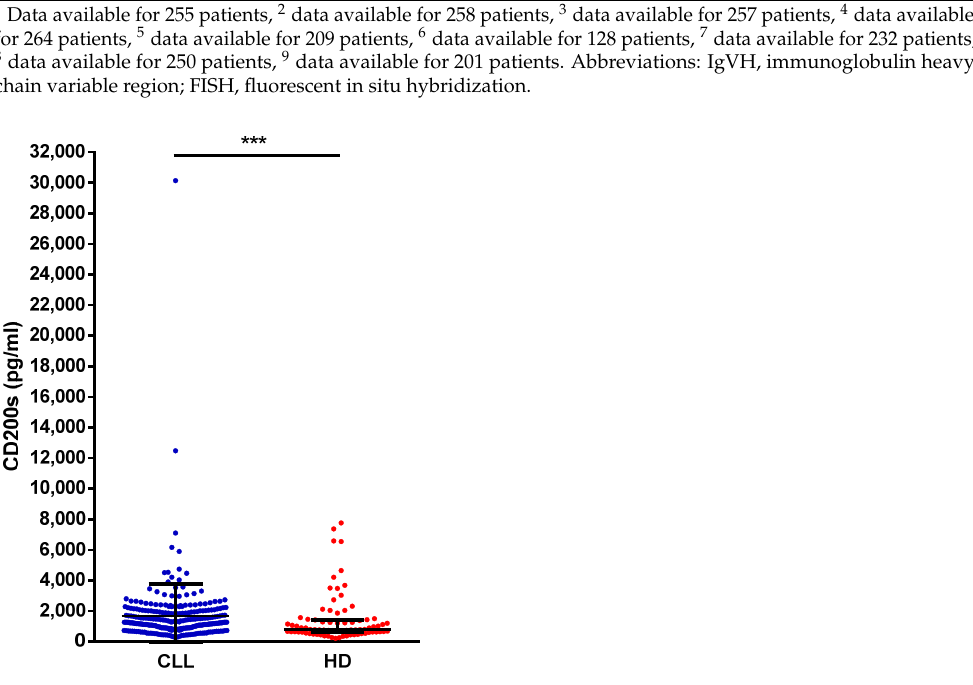
Figure 1. sCD200 in patients with CLL and in HD. Each dot represents the value for the sCD200 serum concentration from a single patient sample. Lines represent median values and interquartile ranges. *** p < 0.001.